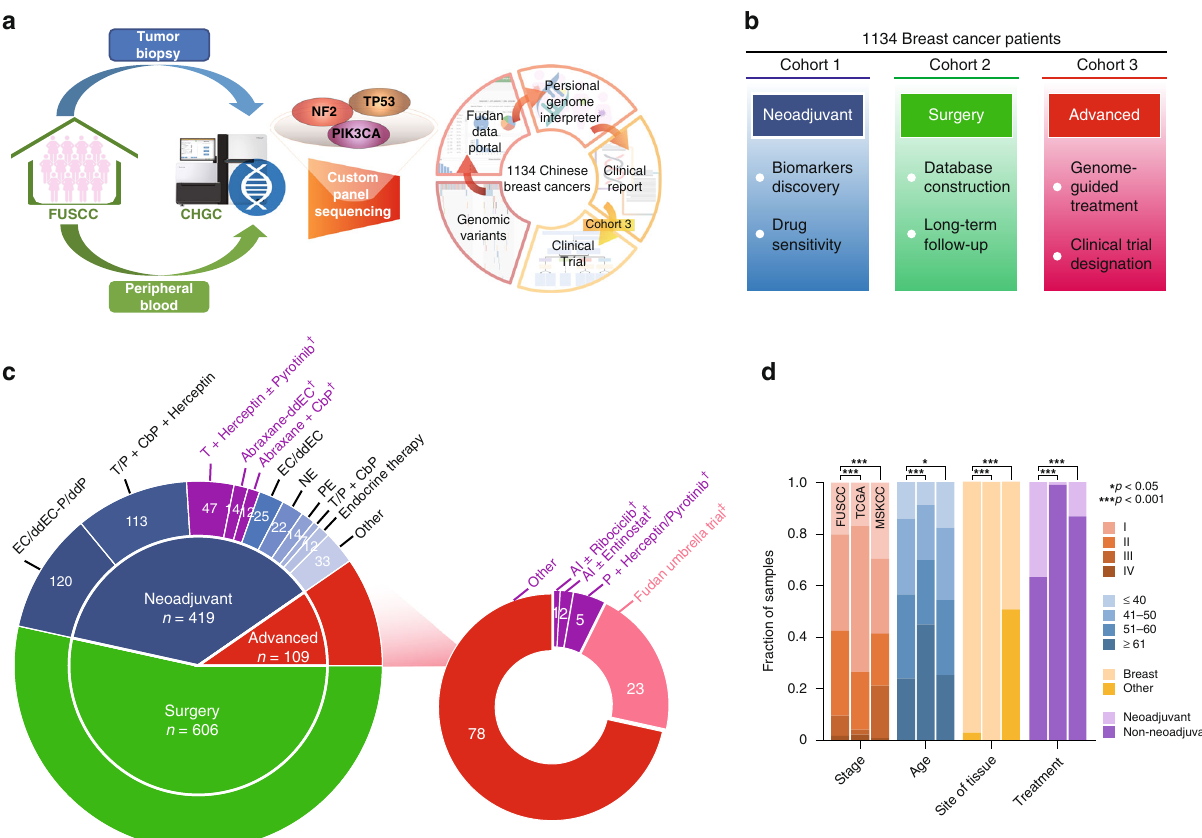
Fig. 1 Schematic of the study and sample distributions. a Schematic of the study. Patients in cohort 3 were referred to genome-guided clinical trials when meeting criteria. b Purpose of the three different investigated cohorts. c Treatment information. † Clinical trial. ‡ Fudan Umbrella Trial. dd dose densed, EC epirubicin + cyclophosphamide, P paclitaxel, T docetaxel, NE vinorelbine + epirubicin, PE paclitaxel + epirubicin, CbP carboplatin, AI aromatase inhibitor. d Clinical features of our prospective cohort compared with those found in previous sequencing studies of breast cancers (MSKCC and TCGA). Source data for d are provided as a source data fi